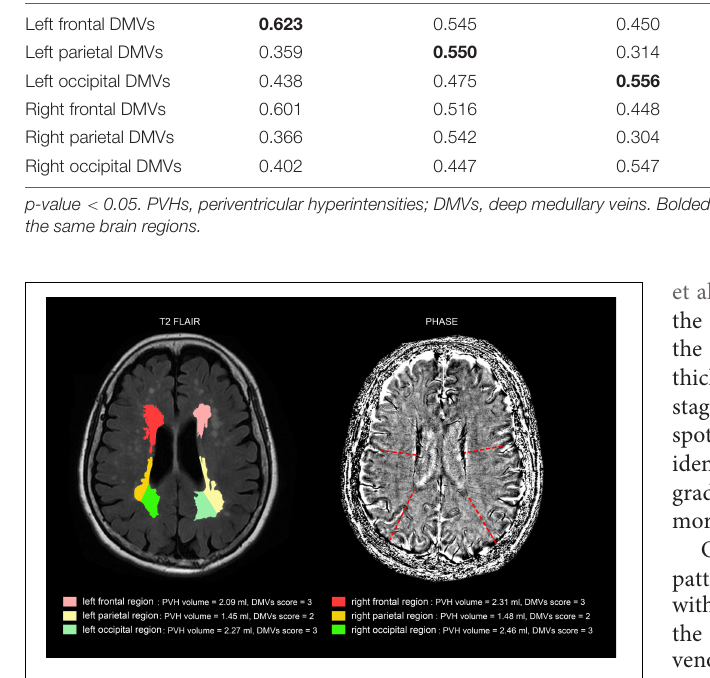
region. Figure 3 was an example figure illustrating the regional correlation between DMVs and